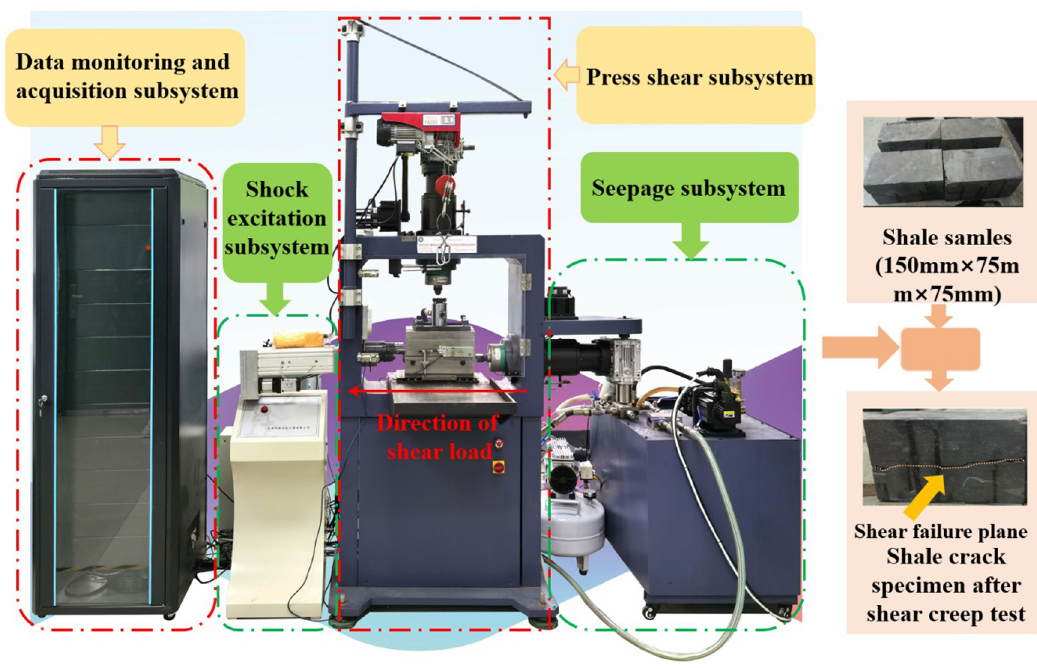
Fig 5. Test samples and equipment.